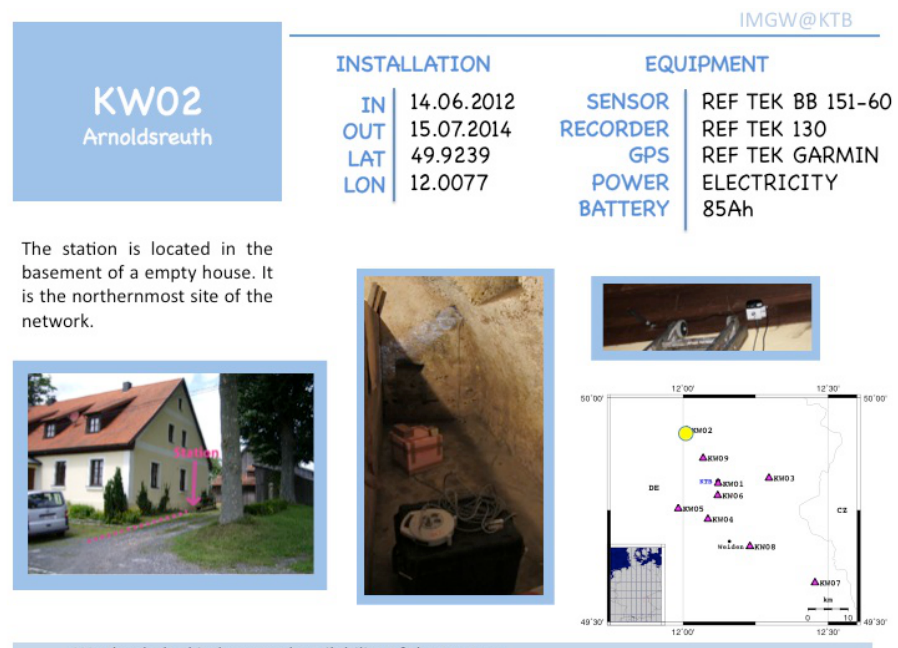
Figure A1. Station KW01 technical information.